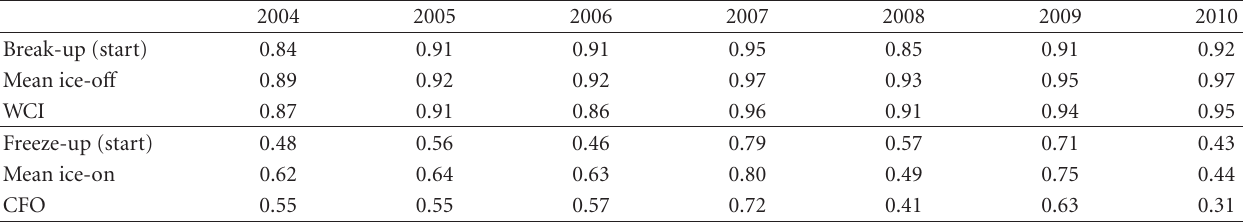
Table 1: Spearman correlation ( R ) values for 189lakes identified with both IMS and MODIS pixels. All values are significant at the 0.001 level.